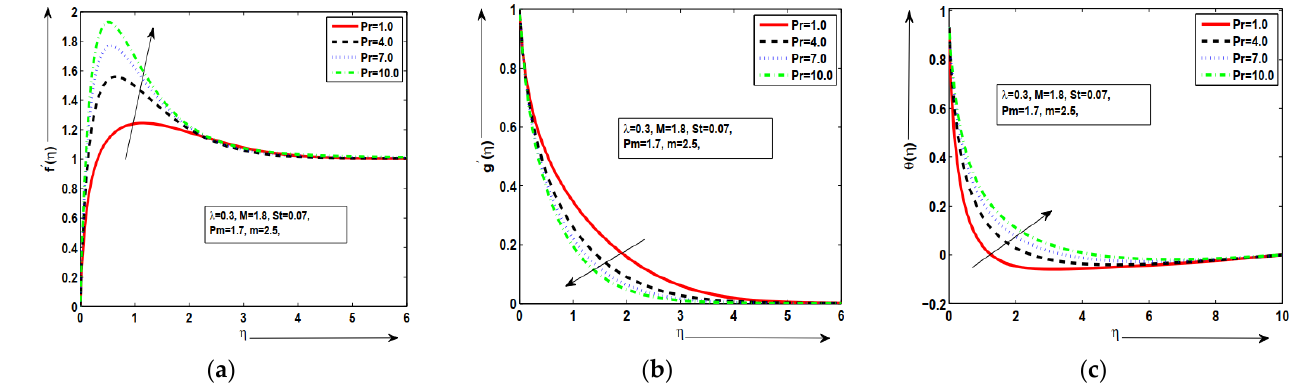
Figure 4. ( a – c ) The geometric profiles of f (cid:48) ( η ) , g (cid:48) ( η ) , and θ ( η ) against λ .